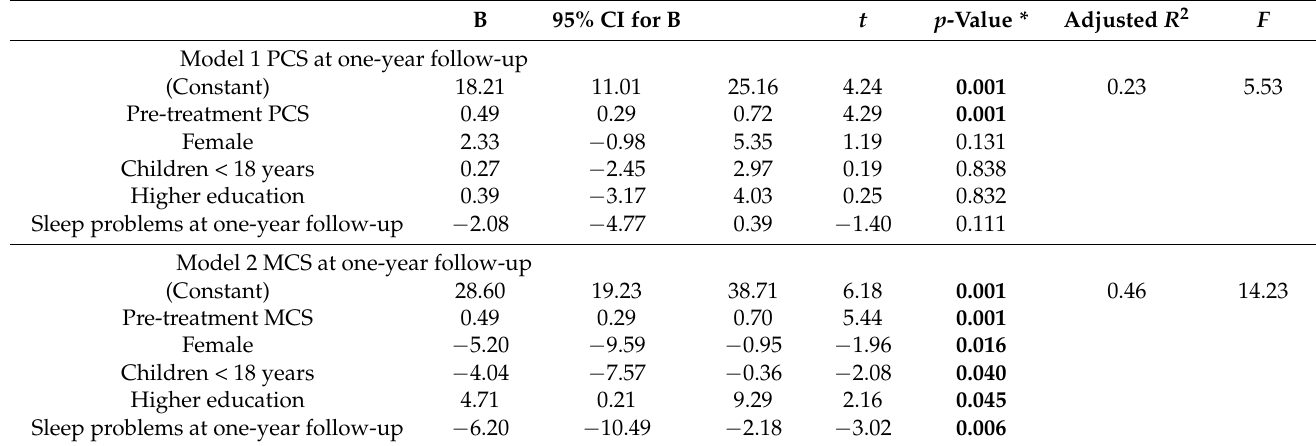
Table 5. Regression models 1 and 2 of potential predictors of PCS and MCS at one-year follow-up. B 95% CI for